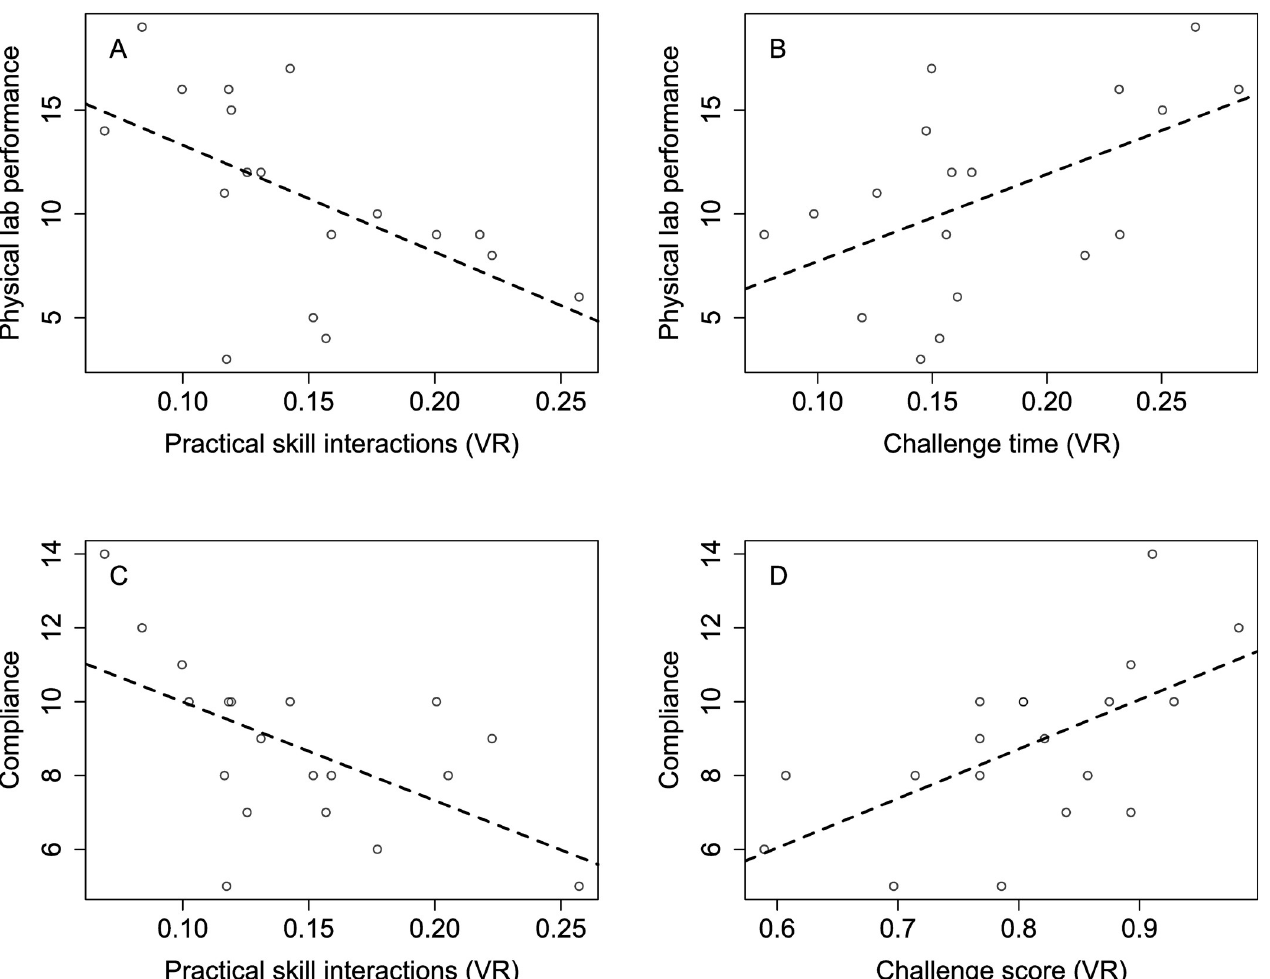
Fig 2. Univariate linear regression models correlating physical lab performance and compliance to virtual reality (VR) simulation behaviometrics. All statistically significant results are presented ( P < 0.05). A: Fewer interactions in the simulation in tasks requiring practical skills led to better lab performance. B: More time in simulation challenges led to better lab performance. C: Fewer interactions in the simulation in tasks requiring practical skills led to higher compliance scores. D: Higher challenge scores in the simulation led to higher compliance scores.